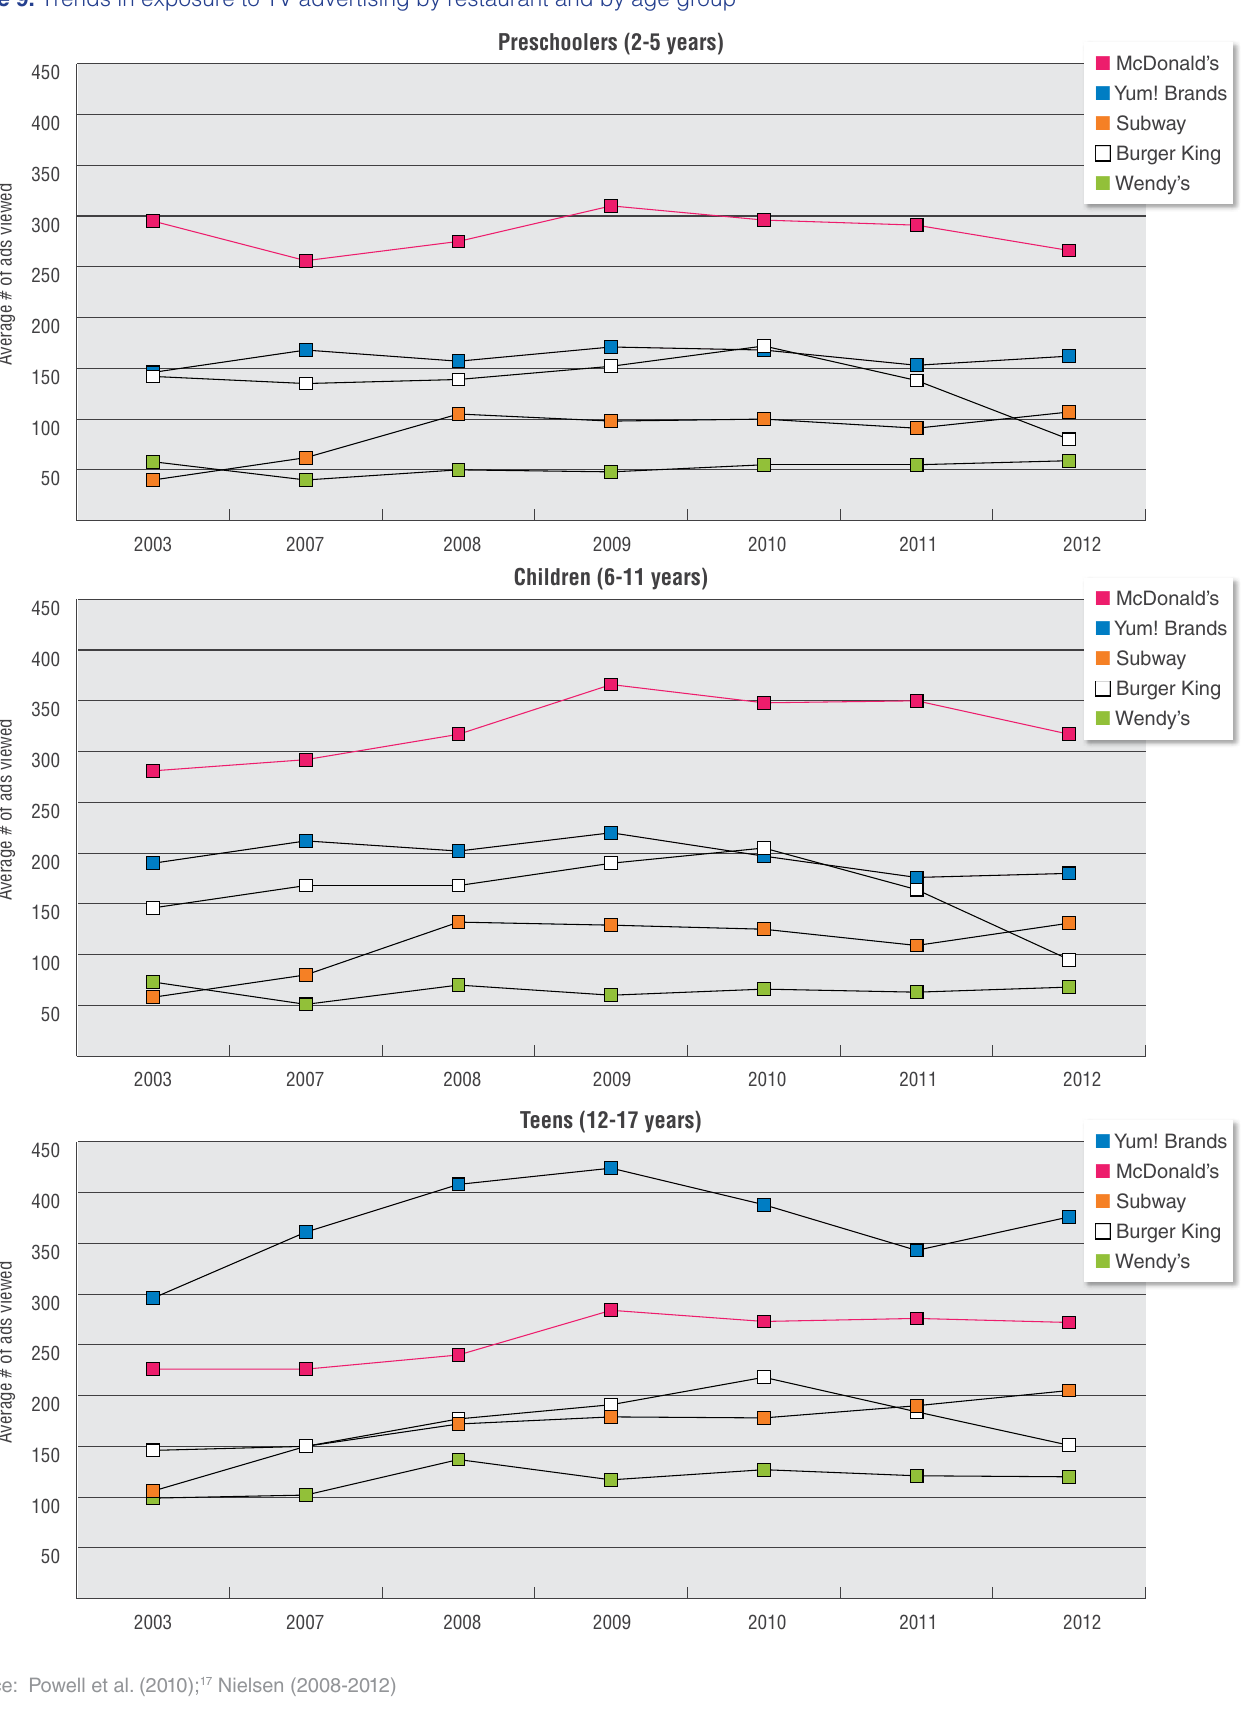
Figure 9. Trends in exposure to TV advertising by restaurant and by age